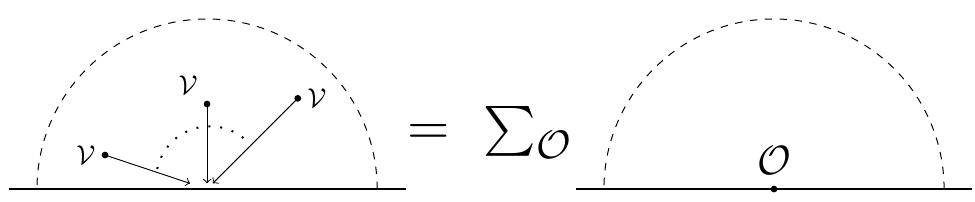
Figure 6. Sketch of the OPE channel relevant to establishing the singular behavior of the correlator in eq. (3.15) as some of the τ 0 . The OPE is obtained, as usual, by projecting the insertions of m → the V operators on the l.h.s. onto a complete set of states on the dashed semicircle. The coefficients of the OPE are higher-point functions involving the insertions of V and the boundary operator O